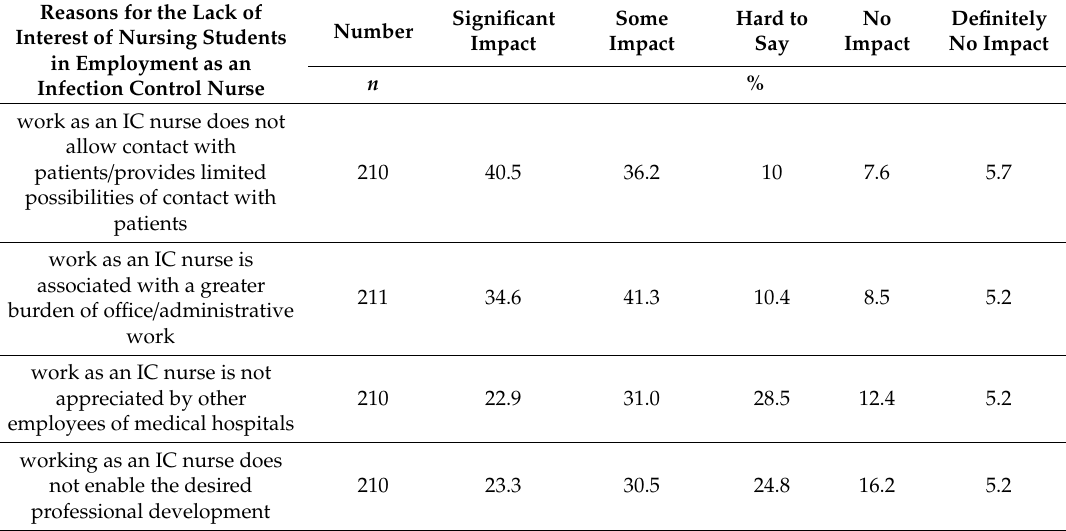
Table A2. Reasons for the lack of interest of nursing students in employment as an infection prevention and control